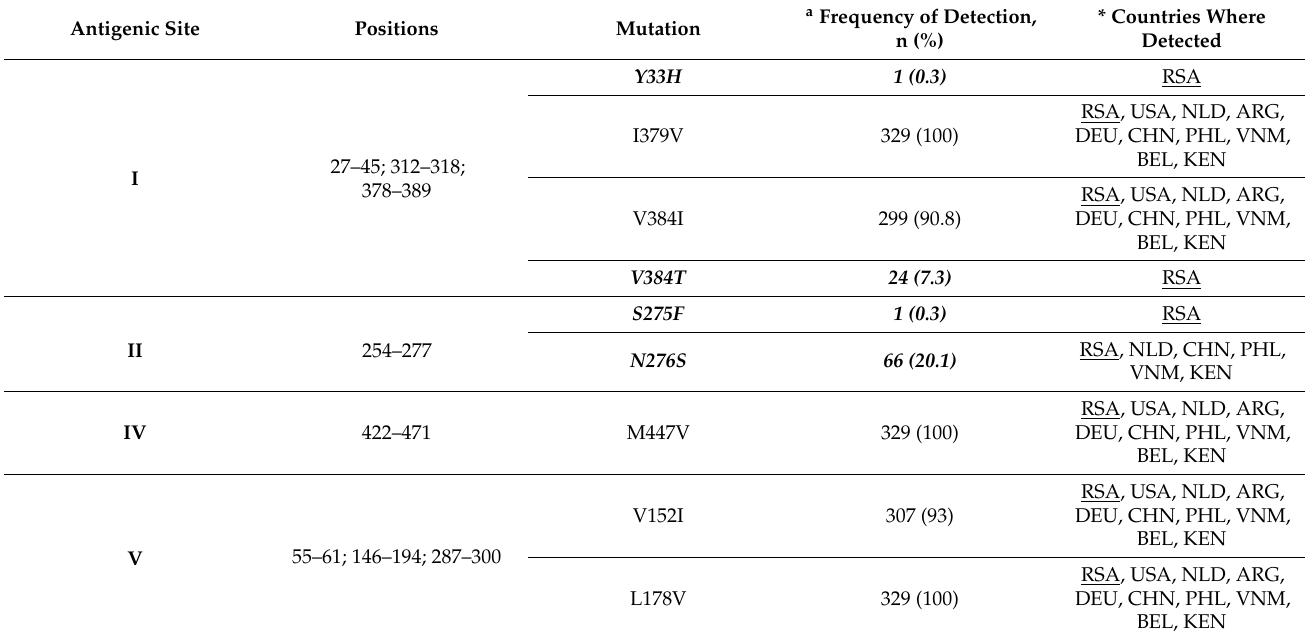
Table 2. Frequency of mutations within the RSV F protein antigenic sites in South African and strains from other countries (N =